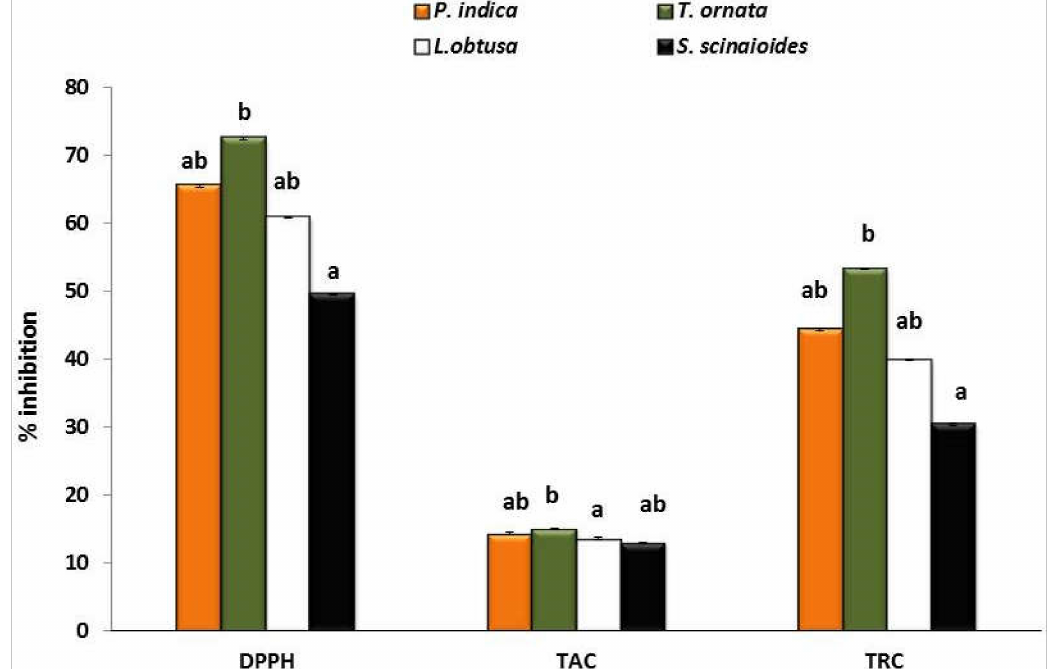
Figure 4. DPPH radical scavenging activity, total antioxidant capacity (TAC), and total reducing capacity (TRC) of the tested seaweed species are expressed as inhibition percentages. Values are the mean of three replicates ± standard deviations (SD). Different letters refer to significant differences between species ( p <